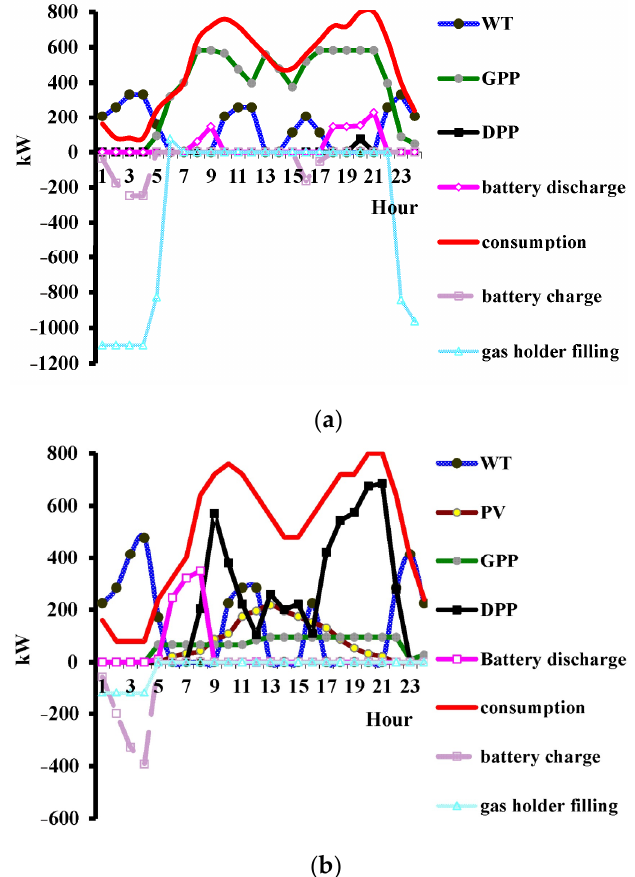
Figure 5. Generated capacity of energy sources: ( a ) North, and ( b ) south.